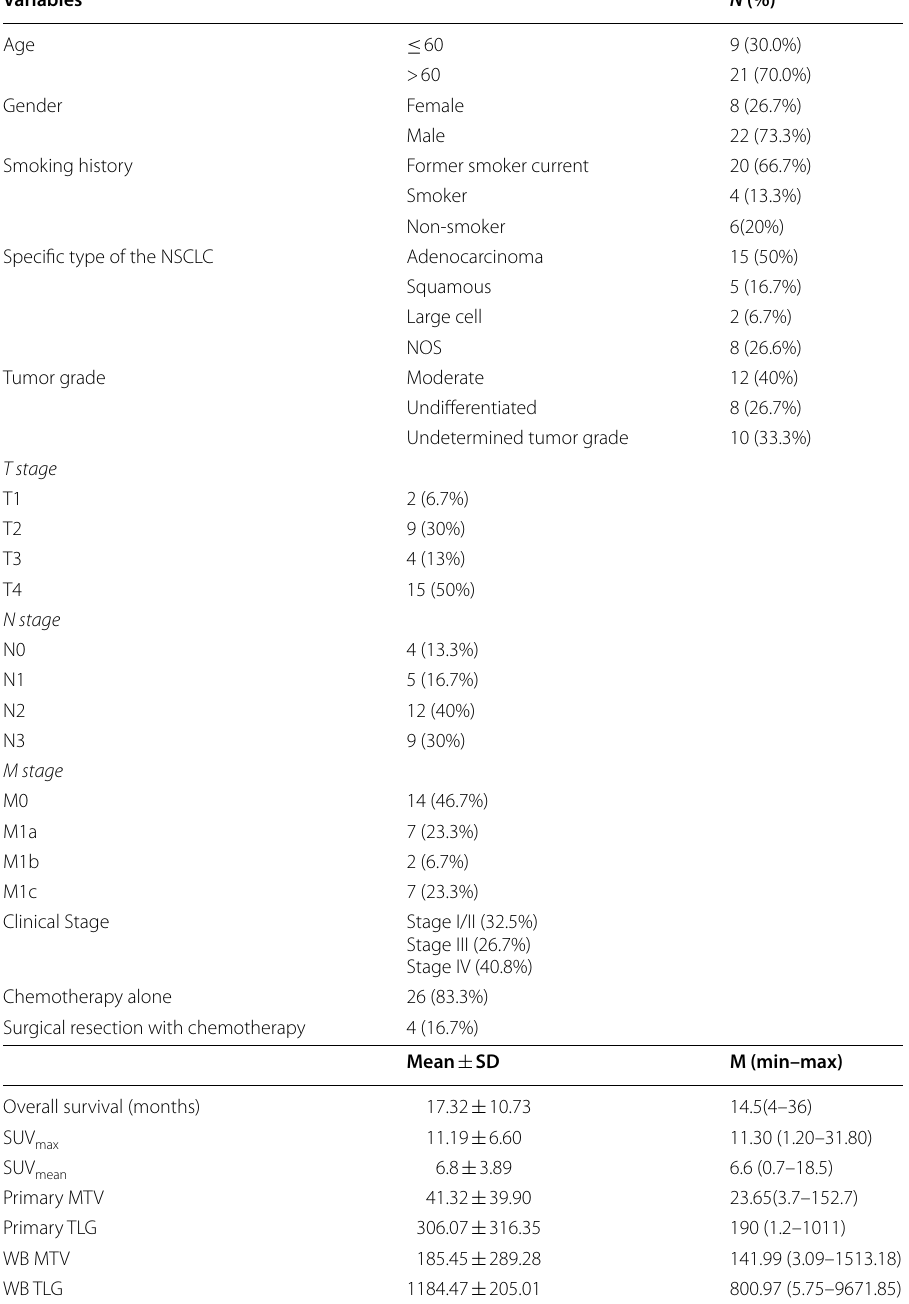
Table 1 Clinicopathological Characteristics of the Studied Patients